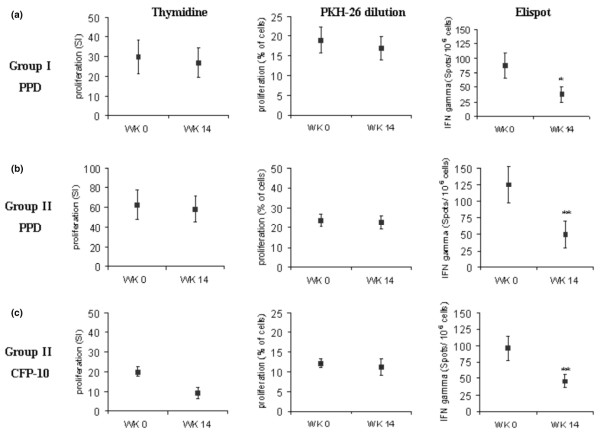
Effect of tumour necrosis factor (TNF) antagonist treatment on anti-mycobacterial responses. The effect of 14-week treatment with a TNF antagonist on the immune response against purified protein derivative (PPD) was determined in patients without a previous or latent tuberculosis group I (a), and in patients with a previous or latent tuberculosis group II (b). The effect of 14-week treatment with a TNF antagonist on the immune response against culture filtrate protein (CFP)-10 was determined in patients with a previous or latent tuberculosis group II (c). The thymidine incorporation, (PKH)-26 dilution, and enzyme-linked immunosorbent spot (ELISPOT) assays were performed, with results expressed (mean ± standard error of the mean) as stimulation indice (SI), fraction of proliferating cells (percentage), and number of interferon (IFN)-γ-producing cells per 106 cells. n = 31 in (a) and n = 25 in (b) and (c). *p < 0.01, **p < 0.005 for comparisons between week 14 and week 0 (Wilcoxon test).